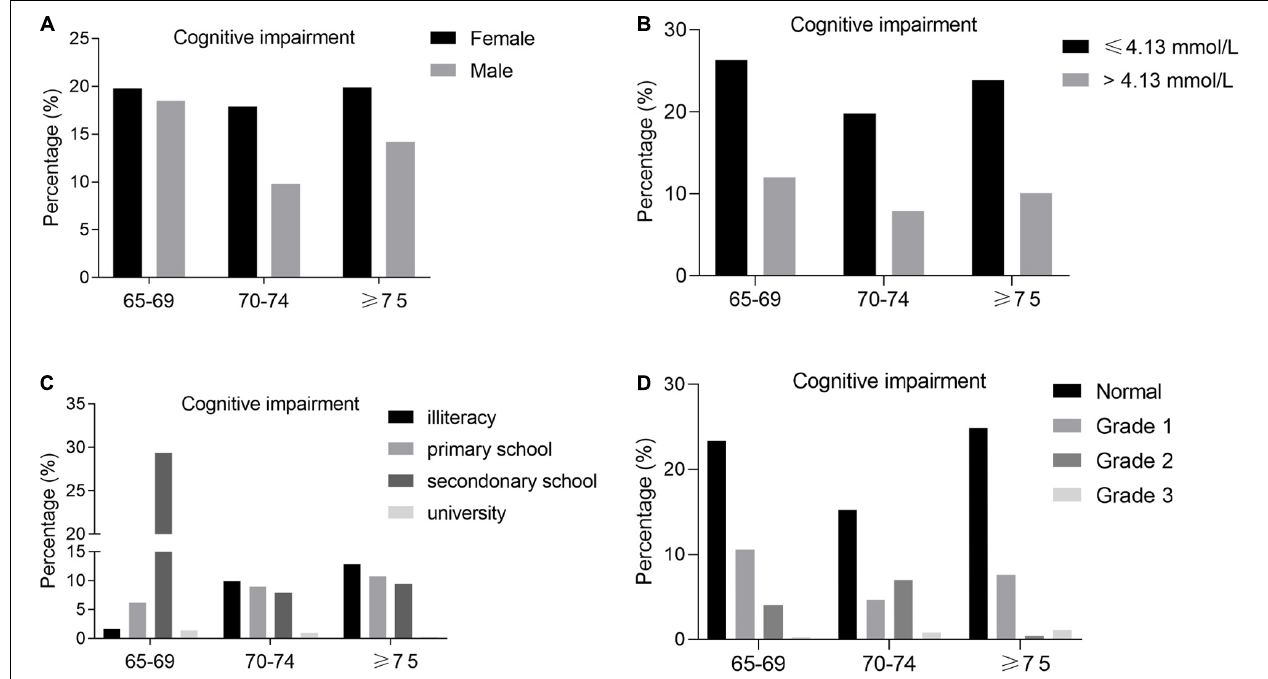
FIGURE 3 | (A) Prevalence of cognitive impairment by gender and age group. (B) Prevalence of cognitive impairment by LDL-C and age group. (C) Prevalence of cognitive impairment by education level and age group. (D) Prevalence of cognitive impairment by BP and age